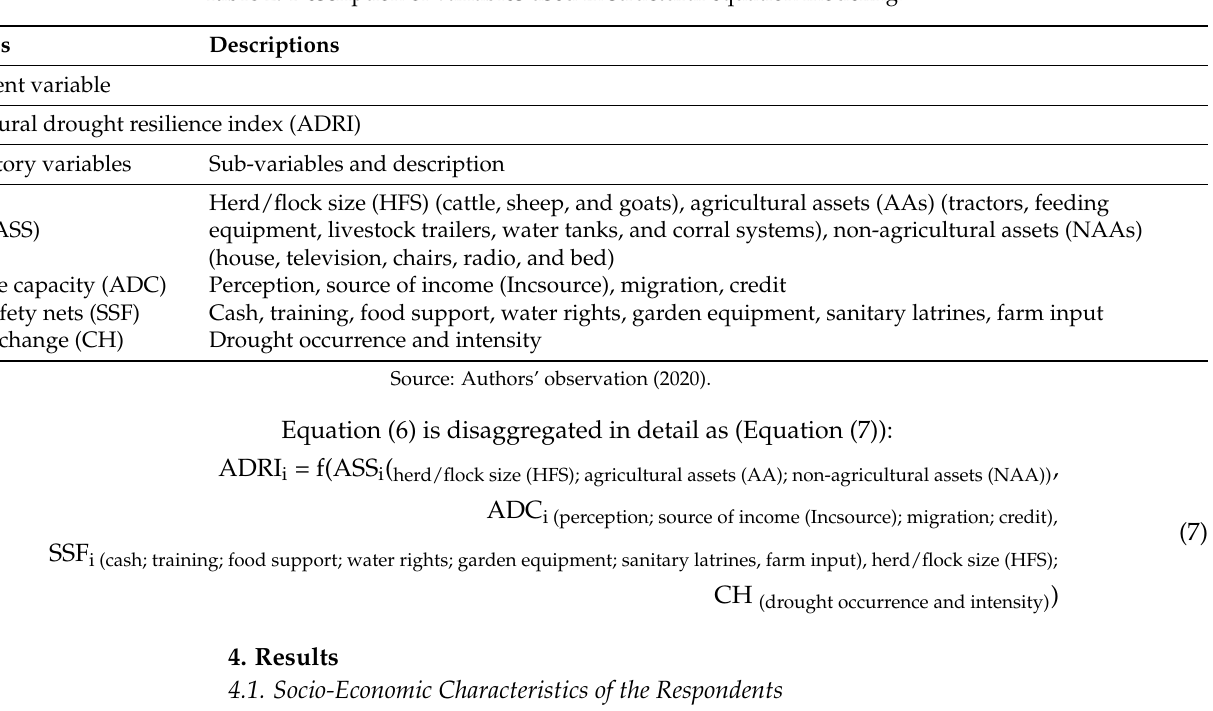
Table 2. Description of variables used in structural equation